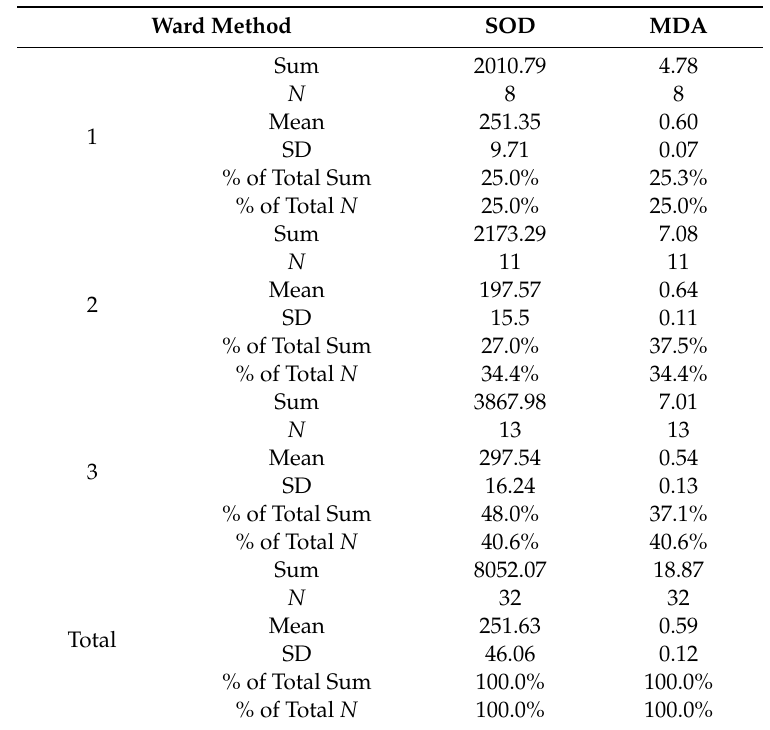
Table 2. Online analytical processing (OLAP) cubes based on the systematic cluster analysis of 32 Chinese teas (cluster number 3).